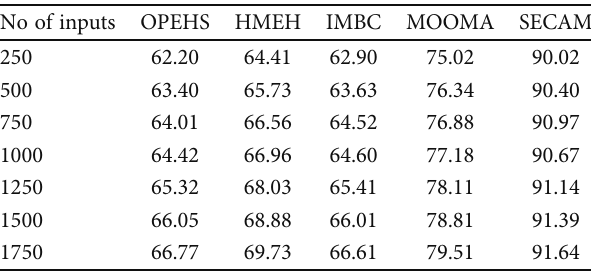
Table 3: Comparison of process acceleration.